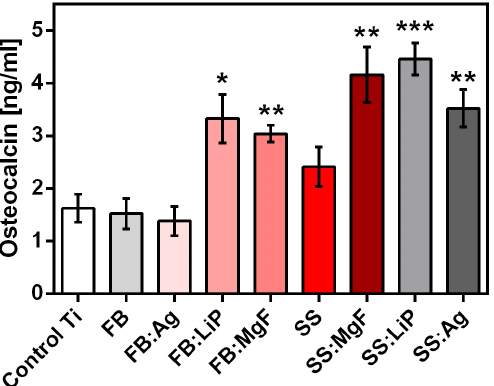
Figure 13. The e ff ect of simple and doped FB and SS thin fi lms on the osteocalcin concentration, 48 Figure 13. The effect of simple and doped FB and SS thin films on the osteocalcin concentration, 48 h h after incubation (* p < 0.05; ** p < 0.01; *** p < 0.0001). after incubation (* p < 0.05; ** p < 0.01; *** p <